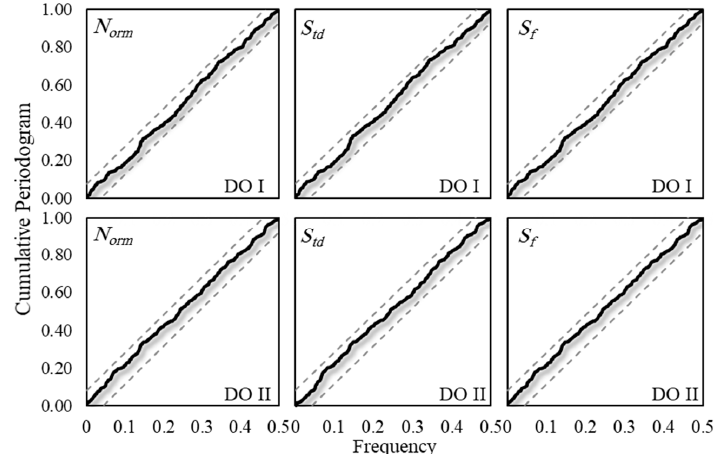
Figure 6. Cumulative periodogram of residuals of ARIMA models for both DO stations I and II.